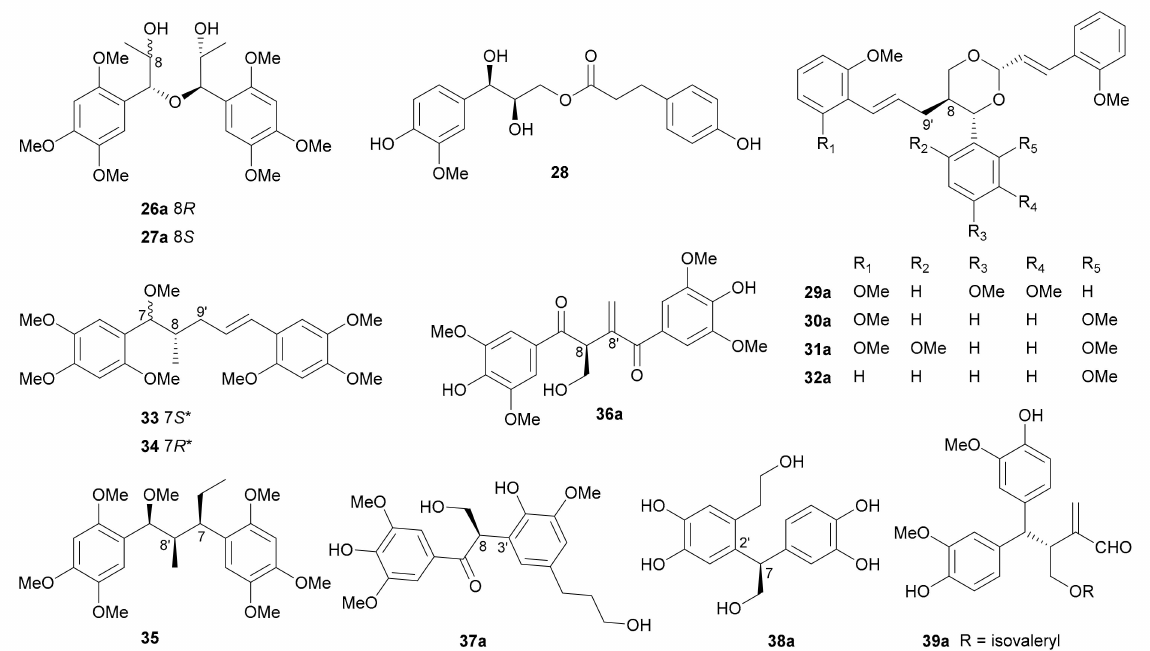
Figure 2. Structures of other acyclic